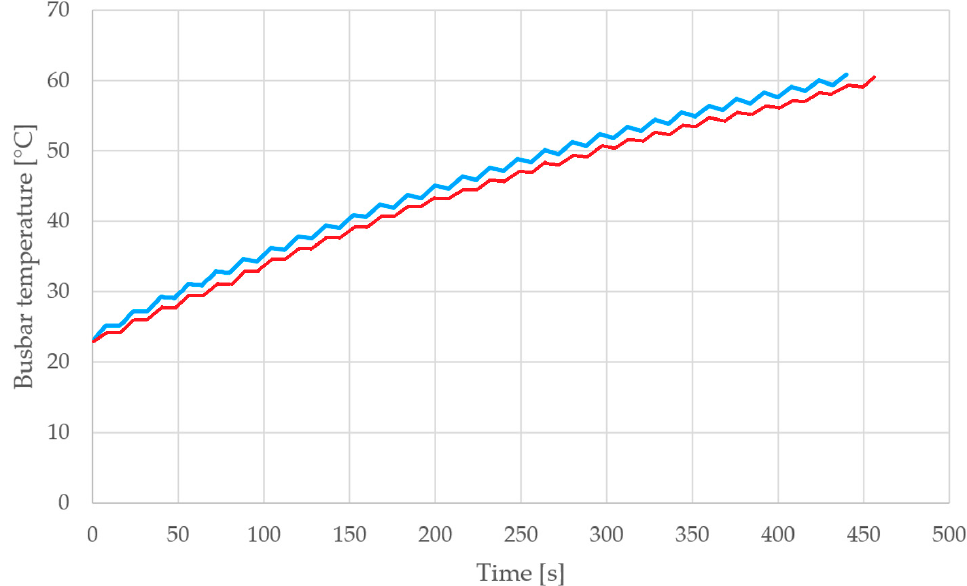
Figure 12. Busbar temperature of a single battery module during acceleration/deceleration cycles 0÷200÷0 km/h; blue line, CFD simulation, red line, experimental test.